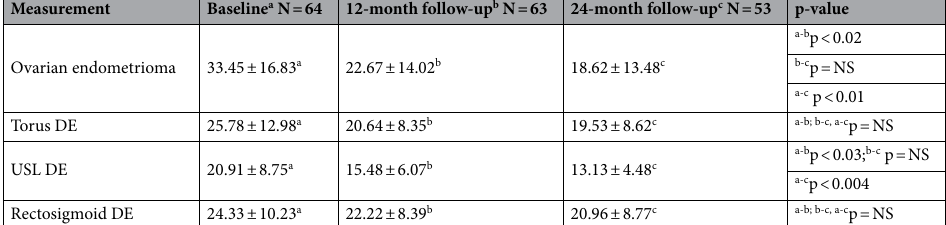
Table 5. Effect of COCs on the sonographic expression of endometriosis at baseline and at 12 and 24 months of follow-up. Results expressed as mean ± standard deviation. Measurement is expressed in millimeters. USL uterosacral ligaments, DE deep endometriosis, NS not significant.